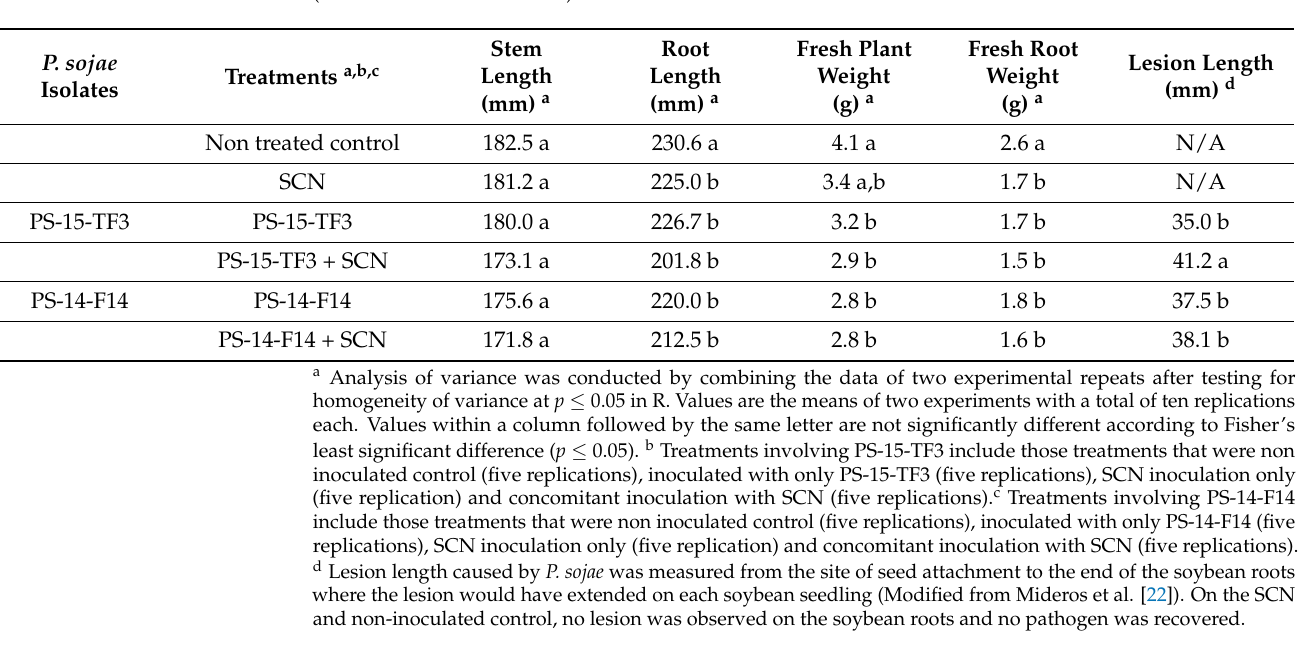
Table 3. Shoot, root length and weight, lesion length measurements observed on the soybean cv. Surge inoculated with SCN or concomitant inoculations of SCN with either of the P. sojae isolates (PS-15-TF3 and PS-14-F14).